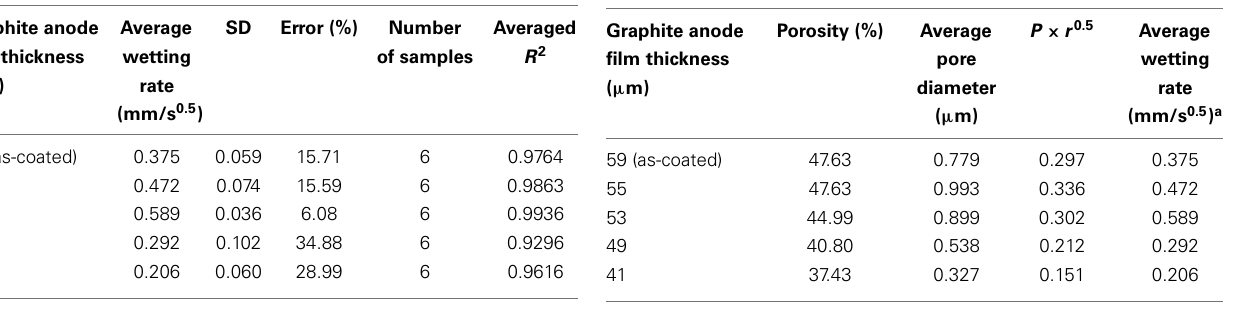
Table 1 | Data summary of results from wetting balance test for all the electrode films .